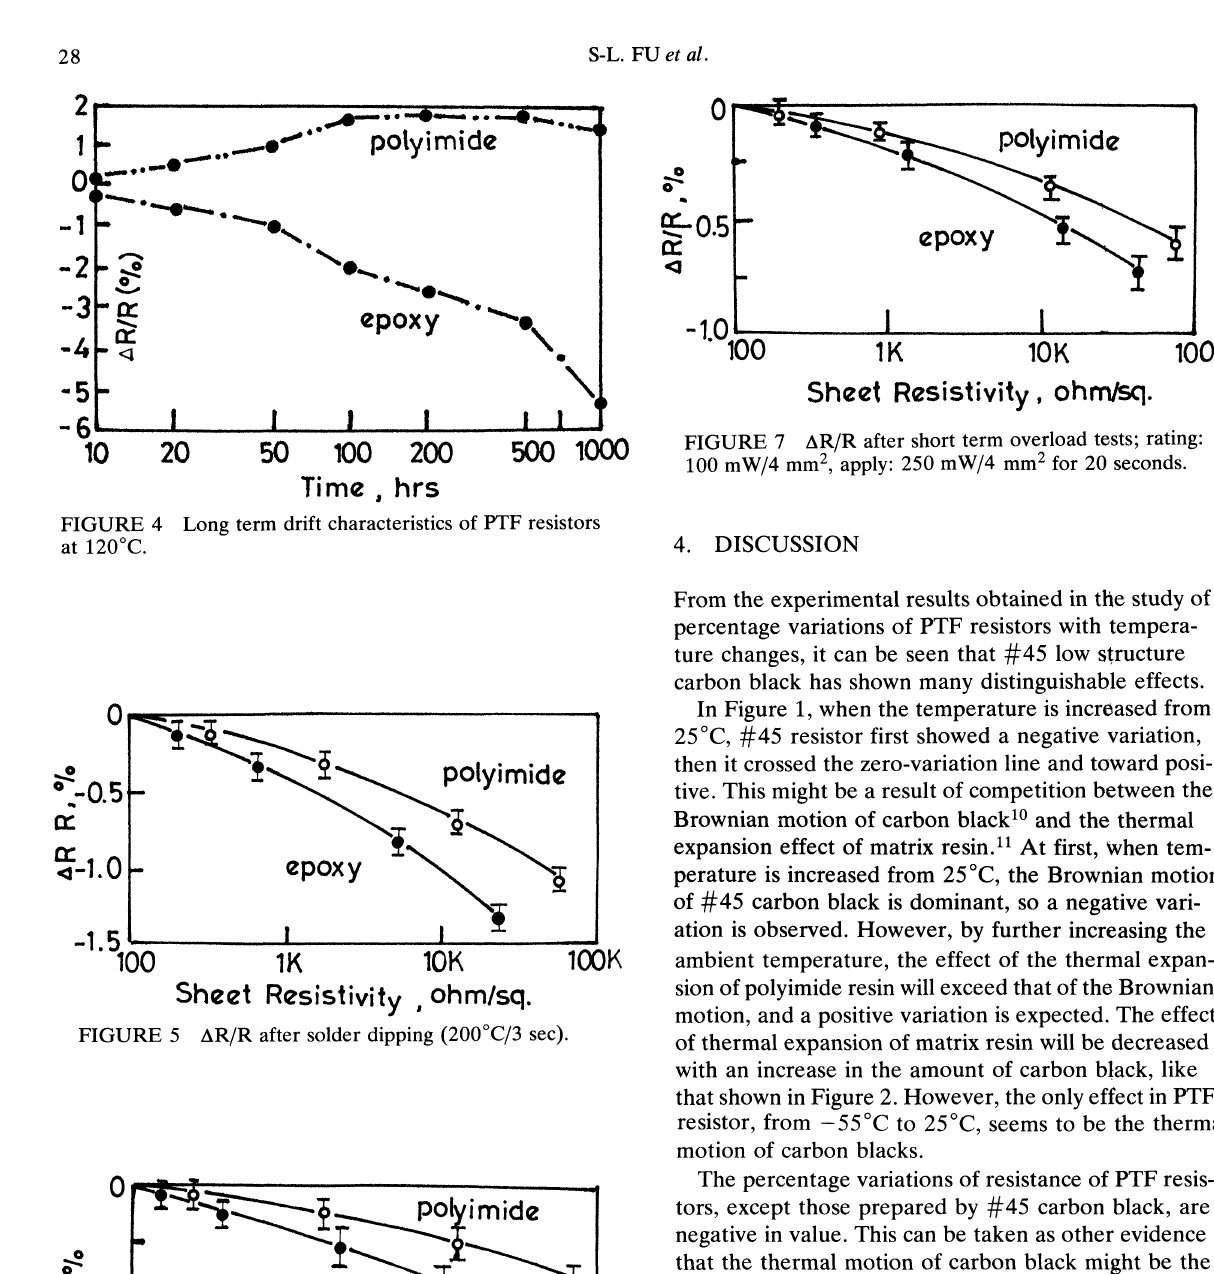
FIGURE 6 AR/R after thermal shock tests; (25 cycles: 100C/30 sec + 0C/30